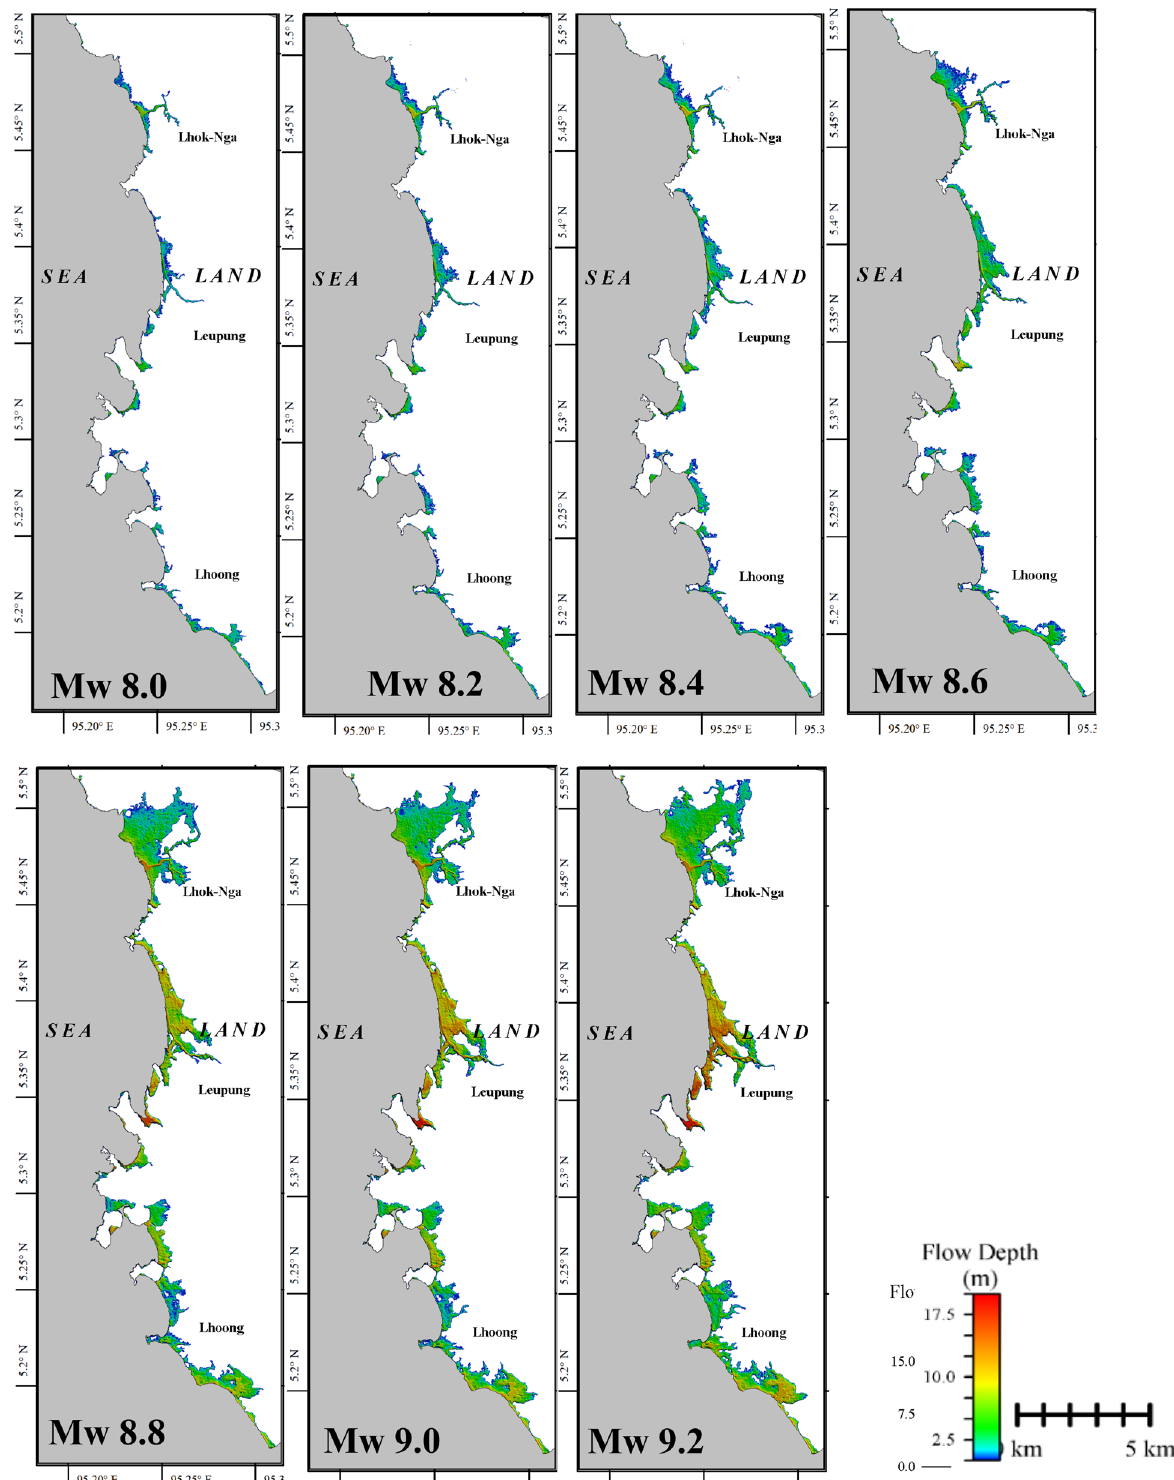
Fig. 7 Inundation map for seven scenarios with earthquake magnitudes from Mw 8.0 to Mw